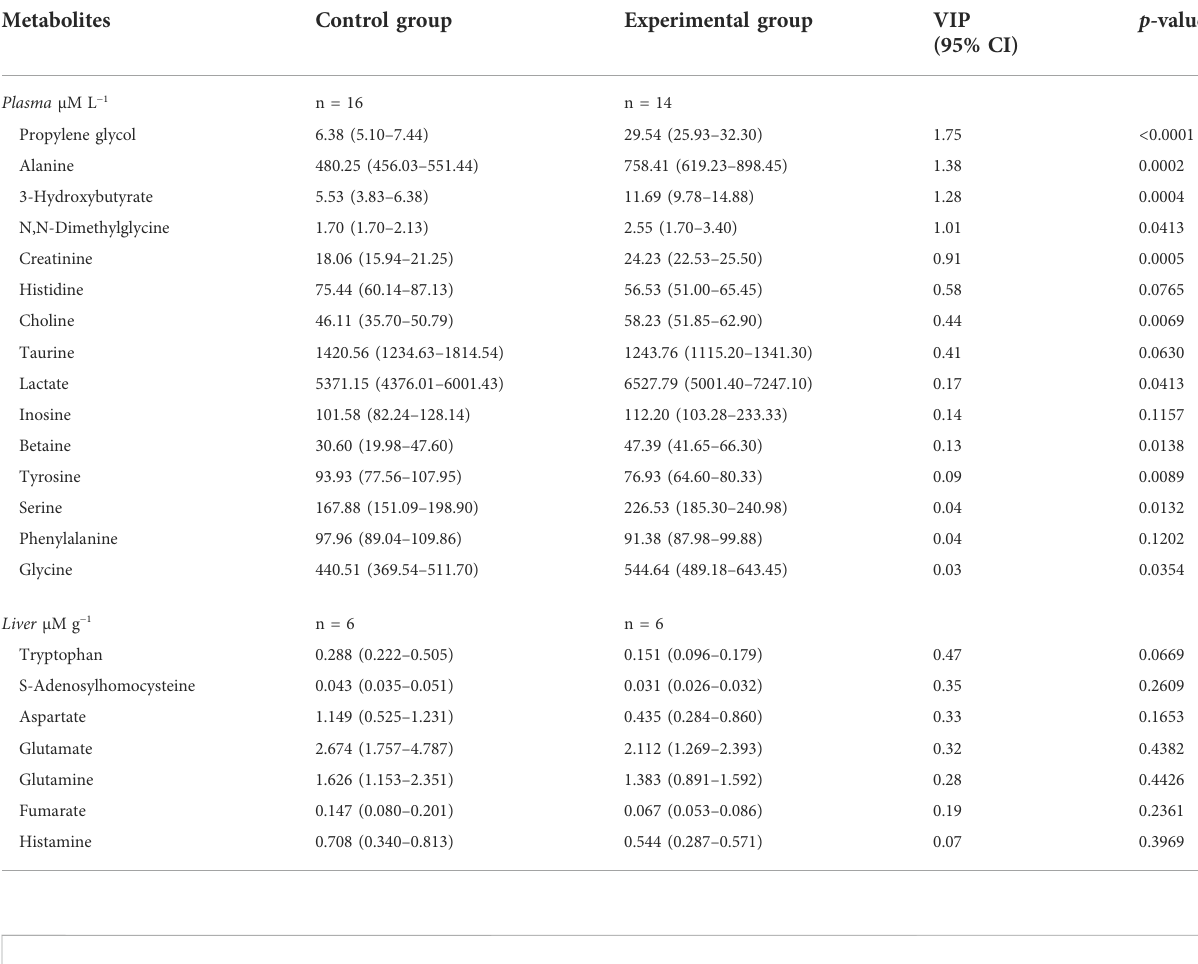
TABLE7Metabolitesinplasmain μ ML − 1 ( n =36intotalwith4missingvalues)andliverinµM g − 1 ( n =12),(totalplasmametabolites=57andtotalliver metabolites = 48). Data are presented as median (Q1-Q3) with concentrations and p -value obtained from PROC MIXED function in SAS 9.4 with